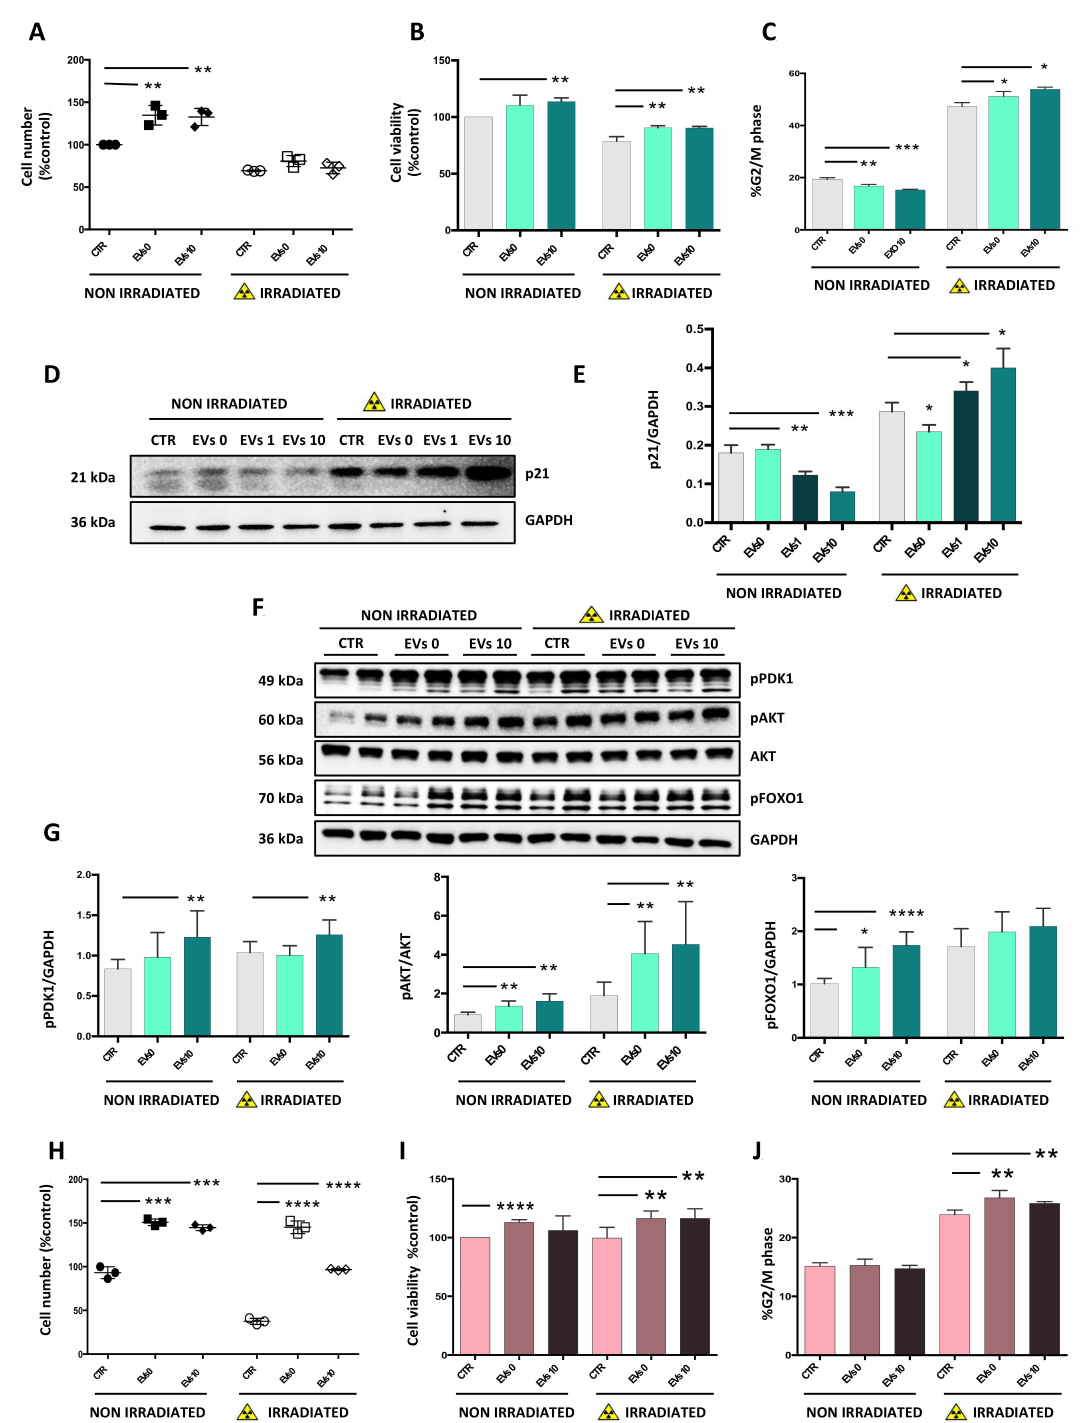
Figure 3. Effects of EVs on viability of recipient cells. Neuroblastoma cells were pre-treated for 1 h with EVs0 or EVs10, and then exposed/mock exposed to X-rays. ( A ) Cell count of SH-SY5Y cells was determined by Trypan blue exclusion assay. ( B ) Viability of SH-SY5Y cells was assessed by the MTT assay 24 h after irradiation. Absorbance was measured at 490 nm. ( C ) Percentages of SH-SY5Y cells in G2-M phase was determined by flow cytometry analysis; ( D ) Protein levels of p21 in SH-SY5Y cells, and ( E ) densitometric relative to three western blots. ( F ) Protein levels of pPDK1, pAKT (T308), AKT, pFOXO1 (Ser256) in SH-SY5Y cells, and ( G ) densitometric relative to three western blots. ( H ) Cell count of SK-N-BE cells determined by Trypan blue exclusion assay. ( I ) Viability of SK-N-BE cells measured by the MTT assay 24 h after irradiation. Absorbance was measured at 490 nm; ( J ) Percentages of SK-N-BE cells in G2-M phase determined by flow cytometry. Data are expressed as means ± S.D. (n = 4, * p < 0.05, ** p < 0.01, *** p < 0.001, **** p < 0.0001 vs.